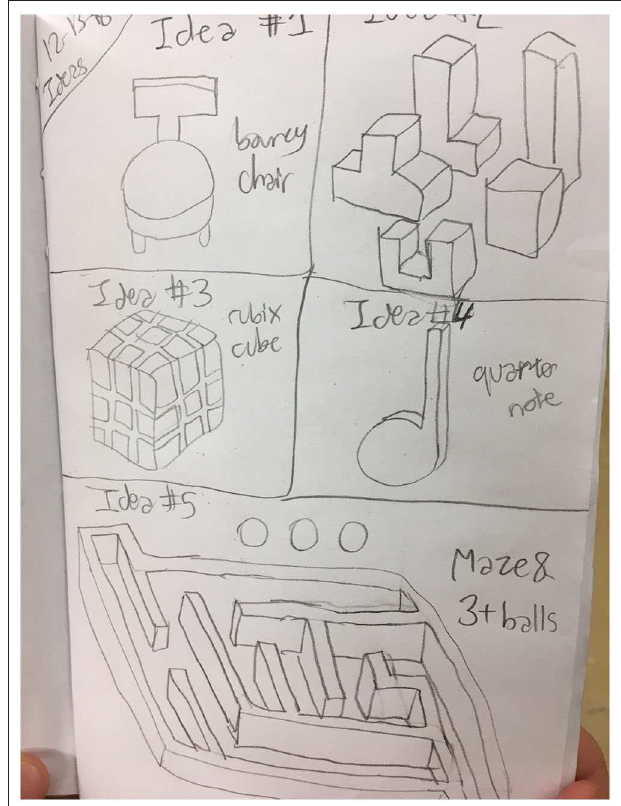
FIGURE 8 | Final Maze